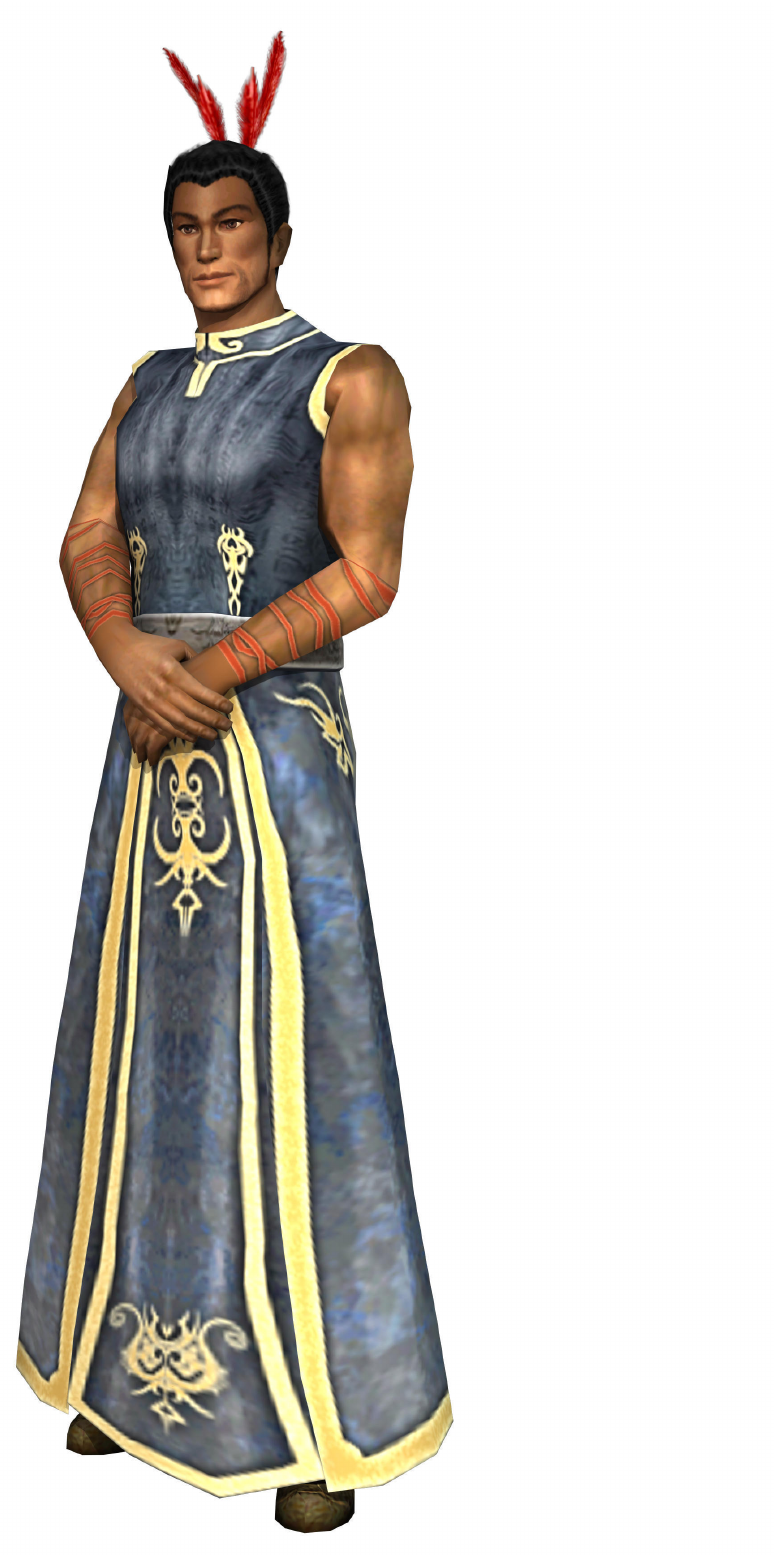
Figure 2. Picture of character from